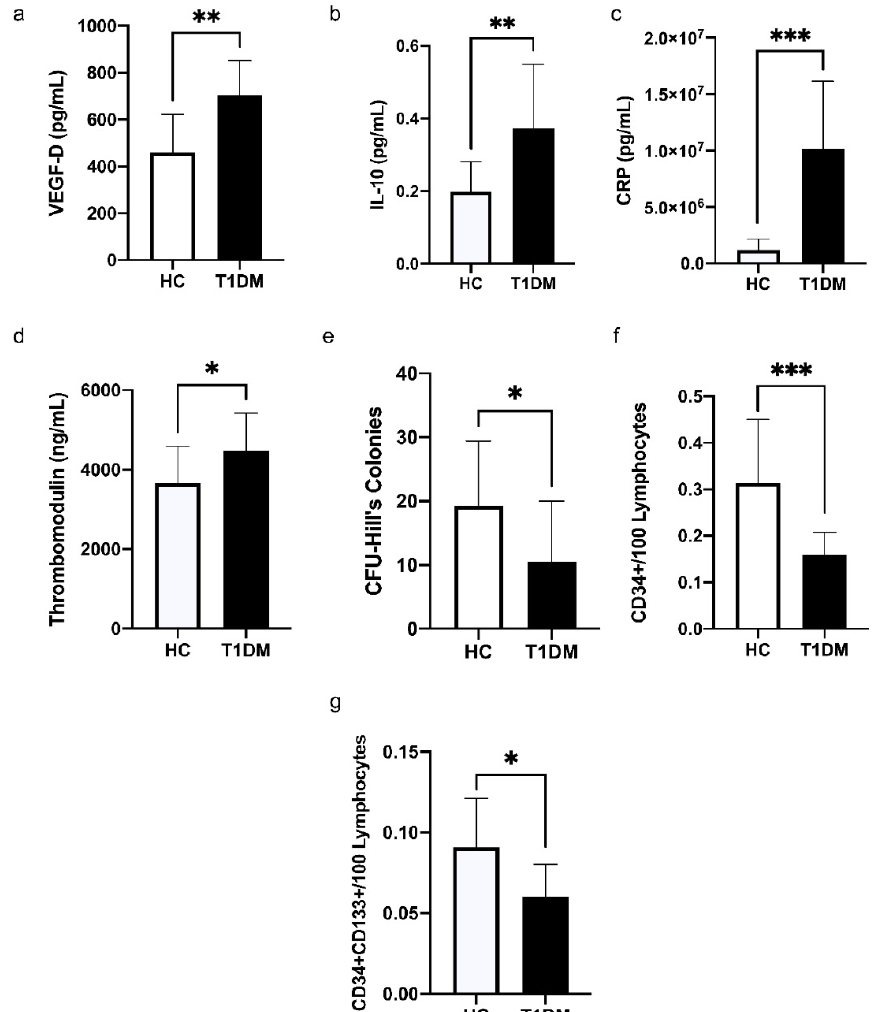
Figure 1. The comparison of data between HC and T1DM patients in terms of the levels of ( a ) VEGF-D in plasma, ( b ) IL-10 in plasma, ( c ) CRP in plasma, ( d ) thrombomodulin in plasma, ( e ) CFU-Hill’s colonies, ( f ) CD34 + /100 lymphocytes, and ( g ) CD34 + CD133 + /100 lymphocytes. Data are presented as means ± SD and analyzed by unpaired t -test or Mann-Whitney U test. VEGF: vascular endothelial growth factor; IL: interleukin; CRP: C-reactive protein; CFU: colony-forming unit; CD: a cluster of differentiation. * p < 0.05; ** p < 0.01; *** p < 0.001.